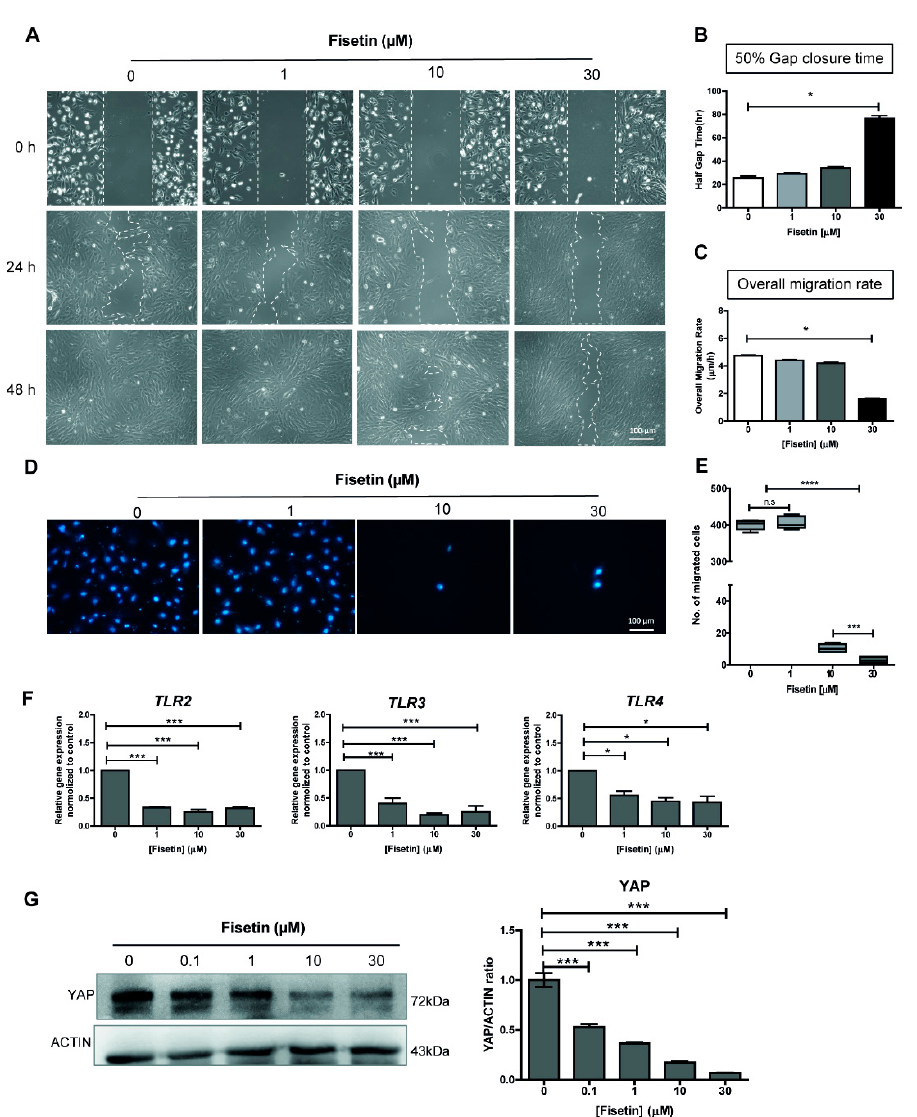
Figure 1. Effect of fisetin on proliferation and migration of MSCs. A scratch was made using a P1000 pipette tip and cultured in the presence of different concentrations of fisetin for 48 h ( A ). The distance between edges was monitored by PAULA ® time-lapse microscopy to determine the 50% gap closure time ( B ), and the overall migration rate upon fisetin treatment ( C ). Representative pictures of cells at the bottom side of the inserted chamber after 6 h incubation stained with Hoechst-33342 ( D ). The number of migrated cells was counted and reported as mean ± SD; n = 3 ( E ). Expression level of TLR2, TLR3, and TLR4 genes upon fisetin treatment ( F ). YAP expression upon fisetin treatment (as determined by Western blotting) and quantitative data ( G ). The data presented in subfigure ( B – E ) were analyzed Mann–Whitney U test. Bars indicate mean values + standard deviation (SD) and asterisks indicate differences * p < 0.05; *** p < 0.001; **** p < 0.0001, n.s. = no significant difference .